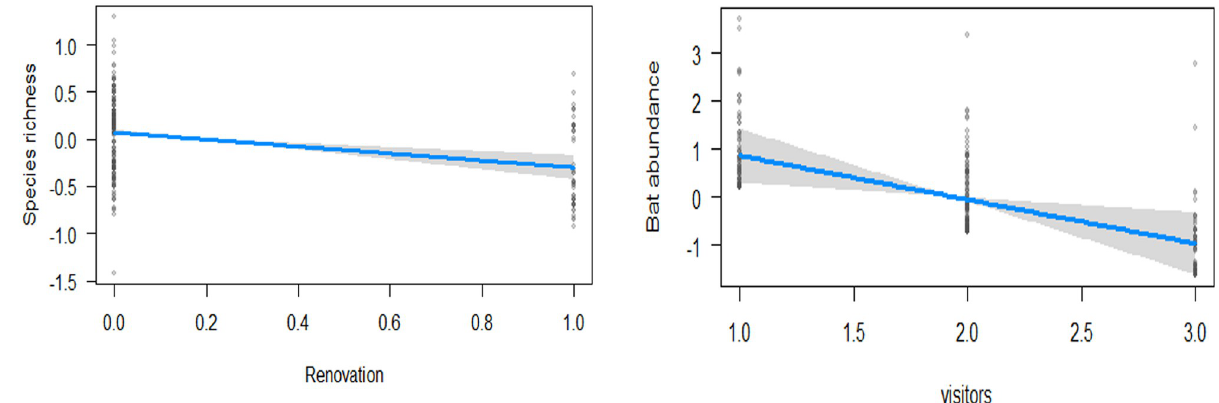
Fig 3. Effects plots showing the relationship of disturbance (Renovation and number of visitors) on species richness and abundance.